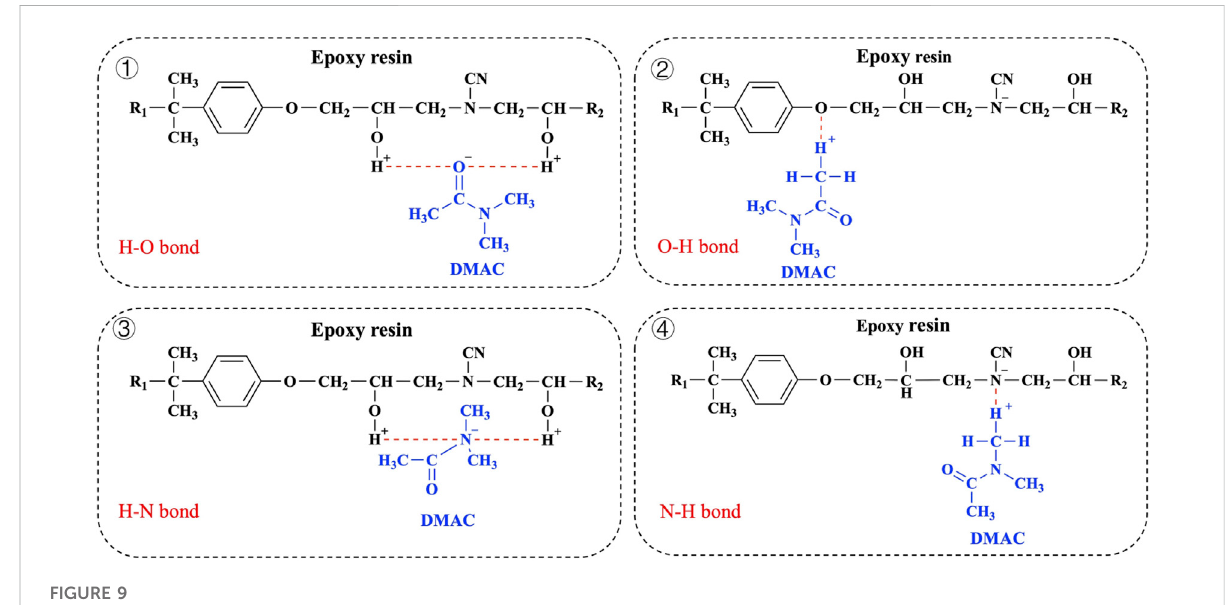
FIGURE 9 Possible swelling mechanism of CEP in DMAC